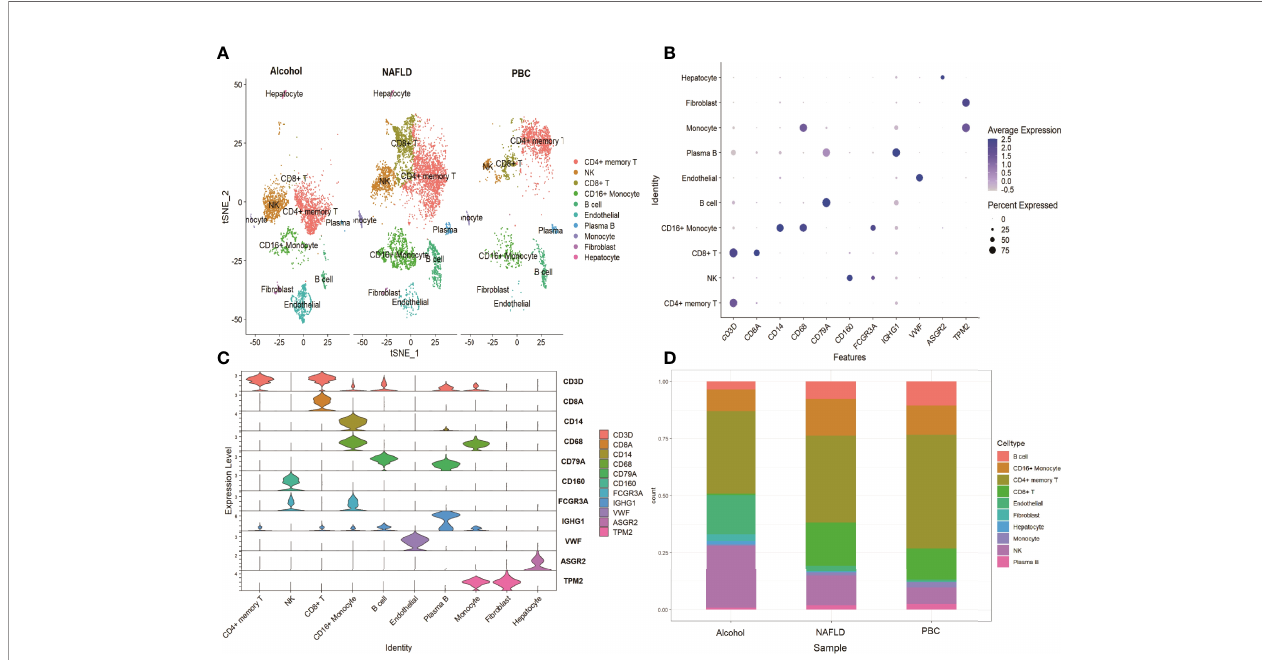
FIGURE 6 | scRNA analysis of cirrhosis by different causes. (A) tSNE projection of the alcohol group, the NAFLD group and the control group. (B) Dot plot of cell type marker genes. (C) Violin plot depicts the distributions of cell type marker genes in each cluster using density curves. (D) Cluster distribution in the three